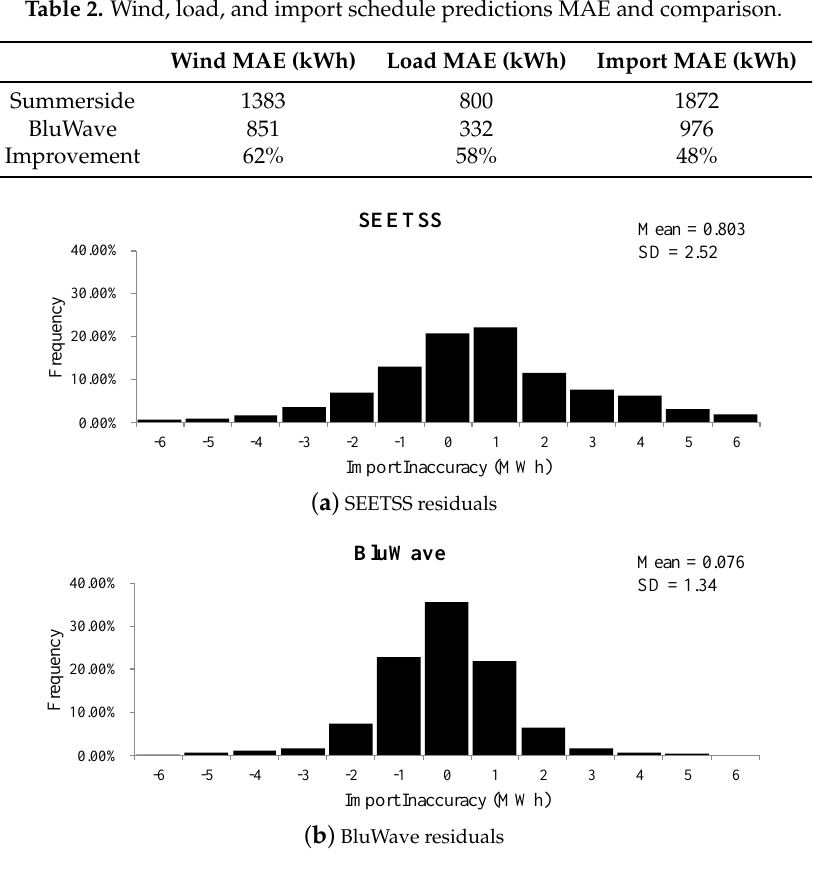
Figure 11. Histogram of Summerside Electric Energy Transmission Scheduling System (SEETSS) and BluWave import schedule